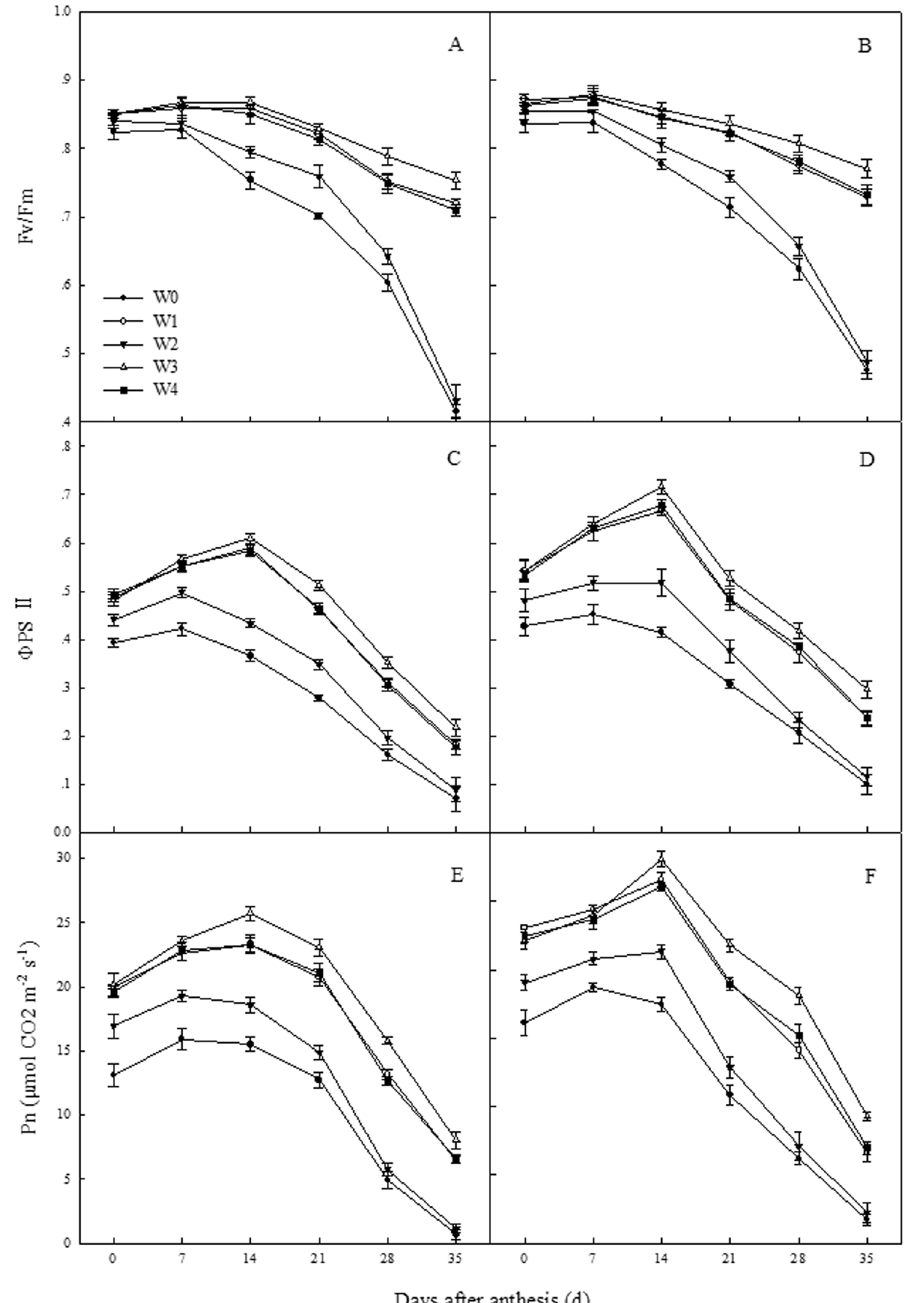
Figure 5. Changes of the Chlorophyll content index (CCI, A and B )maximum quantum yield of the PSII (Fv/ Fm, C and D ) and actual photochemical efficiency ( Φ PSII, E and F ) of different treatments in 2012/2013 ( A , C and E ) and 2013/2014 ( B , D and F ) growing seasons: rainfed (W0), a local supplemental irrigation practice with 60 mm of irrigation each at jointing and anthesis (W1), supplemental irrigation determined by measuring 0–20 cm (W2), 0–40 cm (W3), and 0–60 cm (W4) soil layers moisture and brought the soil moisture to 65% field capacity (FC) at jointing and 70% FC at anthesis. The vertical bars represent standard error of the mean (n =